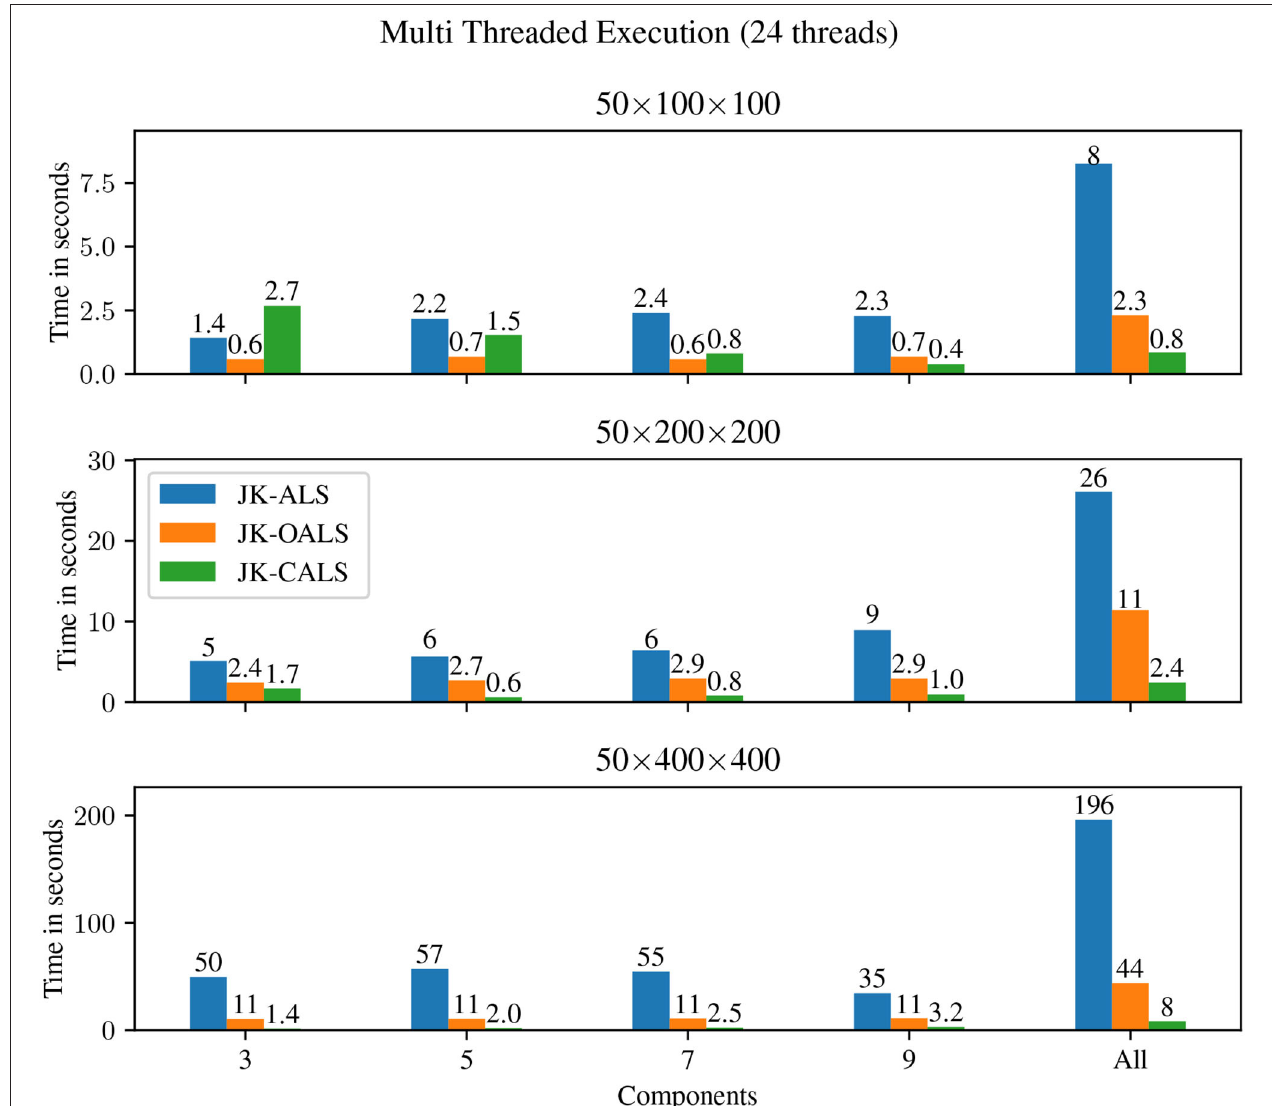
FIGURE 3 | Execution time for multi-threaded (24 threads) jackknife resampling applied to three different tensors (small, medium, and large in the top, middle, and bottom panels, respectively), and different number of components (from left to right: R ∈ { 3,5,7,9 } , and “All”, which represents doing jackknife to all four models